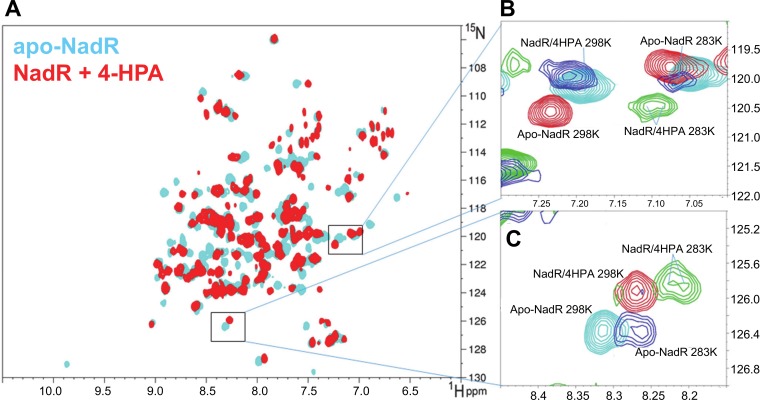
NMR spectra of NadR in the presence and absence of 4-HPA.
(A) Superposition of two 1H-15N TROSY-HSQC spectra recorded at 25°C on apo-NadR (cyan) and on NadR in the presence of 4-HPA (red). (B,C) Overlay of selected regions of the 1H-15N TROSY-HSQC spectra acquired at 25°C of apo-NadR (cyan) and NadR/4-HPA (red) superimposed with the spectra acquired at 10°C of apo-NadR (blue) and NadR/4-HPA (green). The spectra acquired at 10°C are excluded from panel A for simplicity.